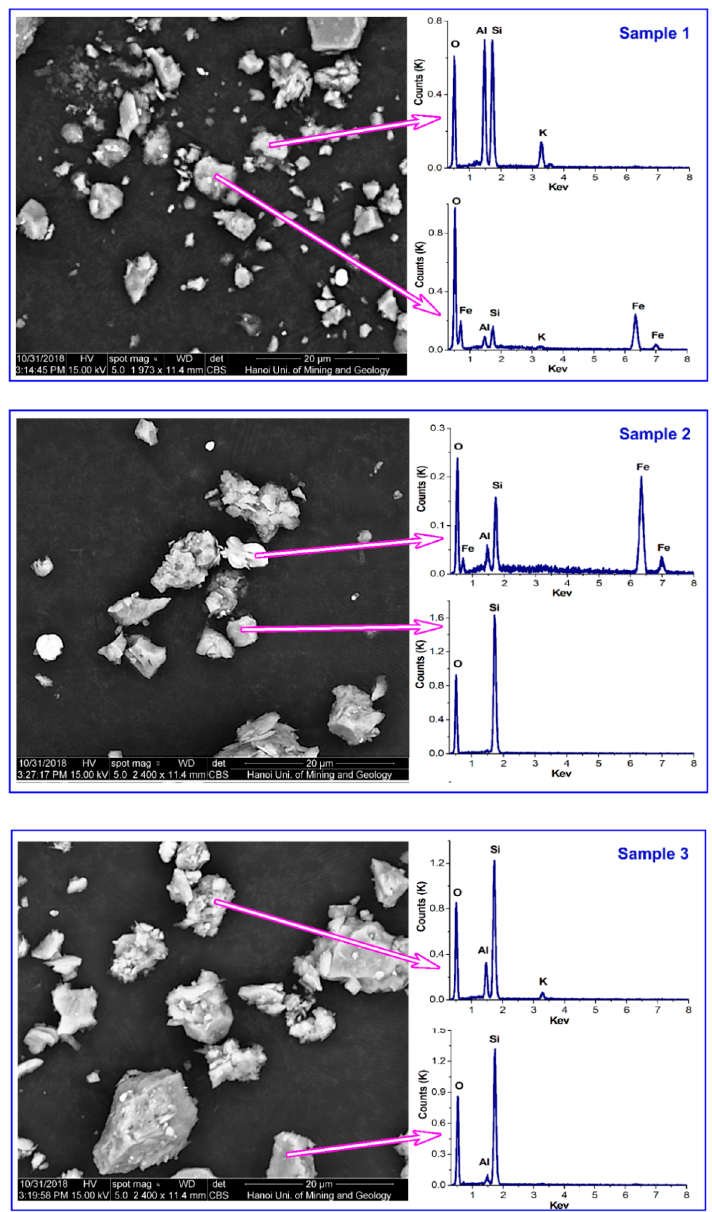
Figure 6. The composition of dust particles in drilling operations at the Coc Sau open-pit coal mine. The y -axis depicts the number of counts, and the x -axis represents the energy of the X-rays.